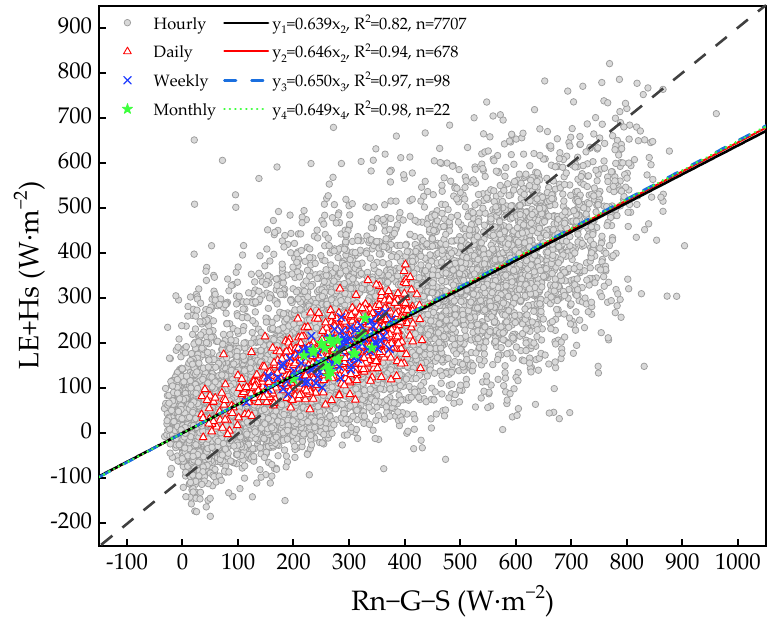
Figure 10. Scatter plots of the turbulent flux versus available energy (hourly, daily, weekly, and monthly). The gray dots are hourly data points, and the black straight line is its fitted line; the red triangles are daily data, and the linear fit result is represented as red straight lines; the dark blue forks indicate weekly data, the linear fit result as blue dashed lines, the green pentagrams are monthly data, and the fitted straight line is represented by green dotted